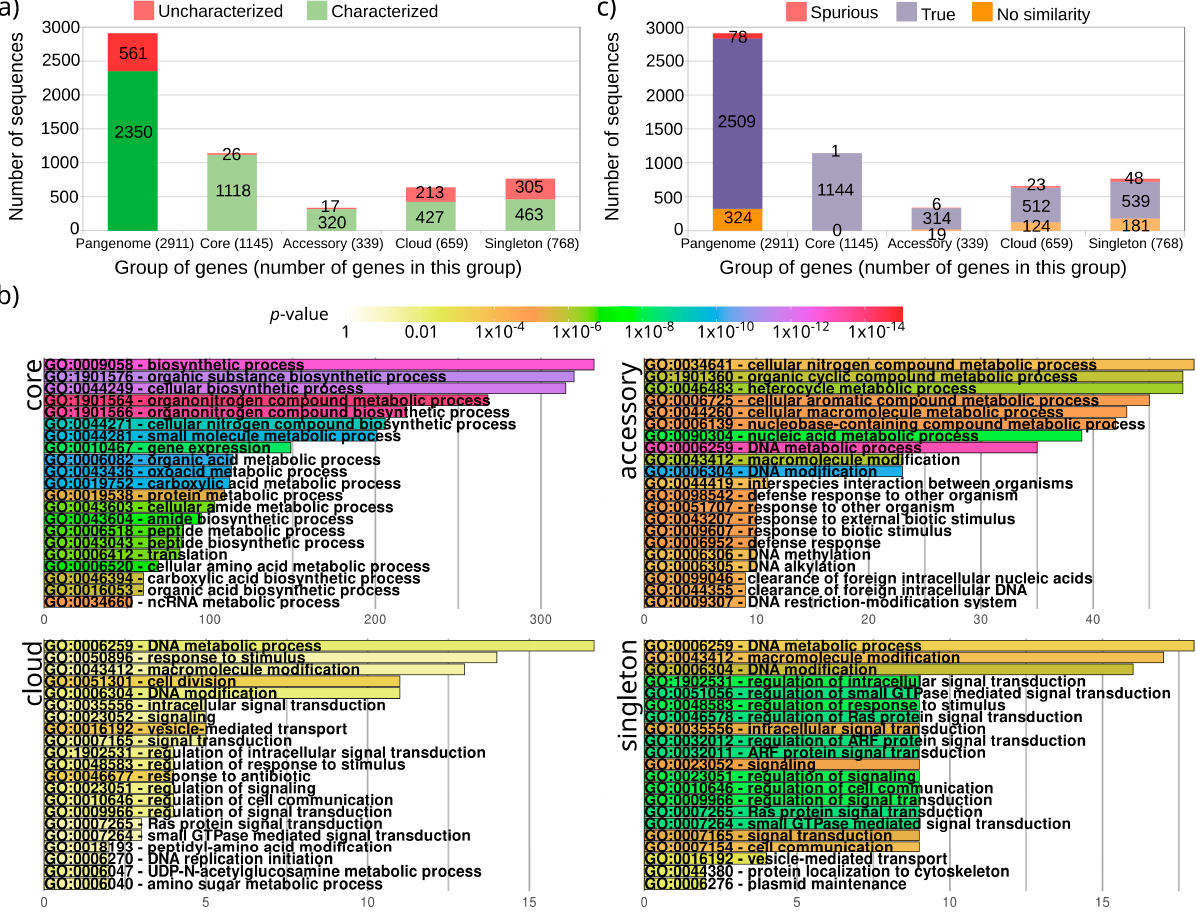
Figure 1. Proteins characterized and uncharacterized in the pangenome and functional enrichment. ( a ) Number of proteins characterized (with annotations) and uncharacterized (without any annotation) in the complete pangenome and in each of its groups. The total number of genes that belong to each group are shown in parentheses. ( b ) Functional enrichment of each group of genes. ( c ) Results of Spurio for proteins in the complete pangenome and in each of its groups: No_similarity (multiple alignment could not be created due to the lack of homologous), True (predicted as true proteins), and Spurious (predicted as spurious proteins).